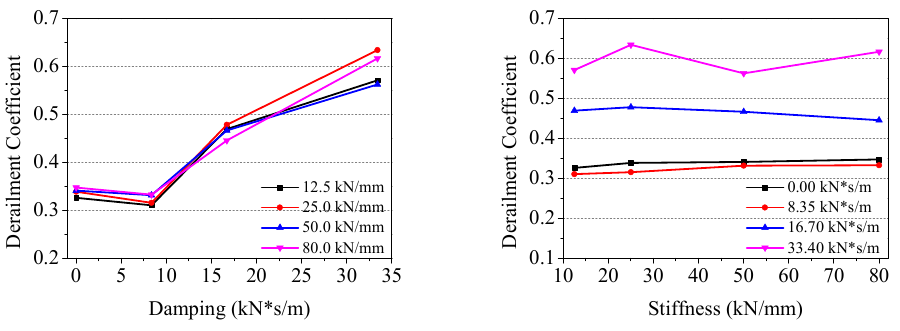
Figure 6. Charts of extreme values of the calculation results.